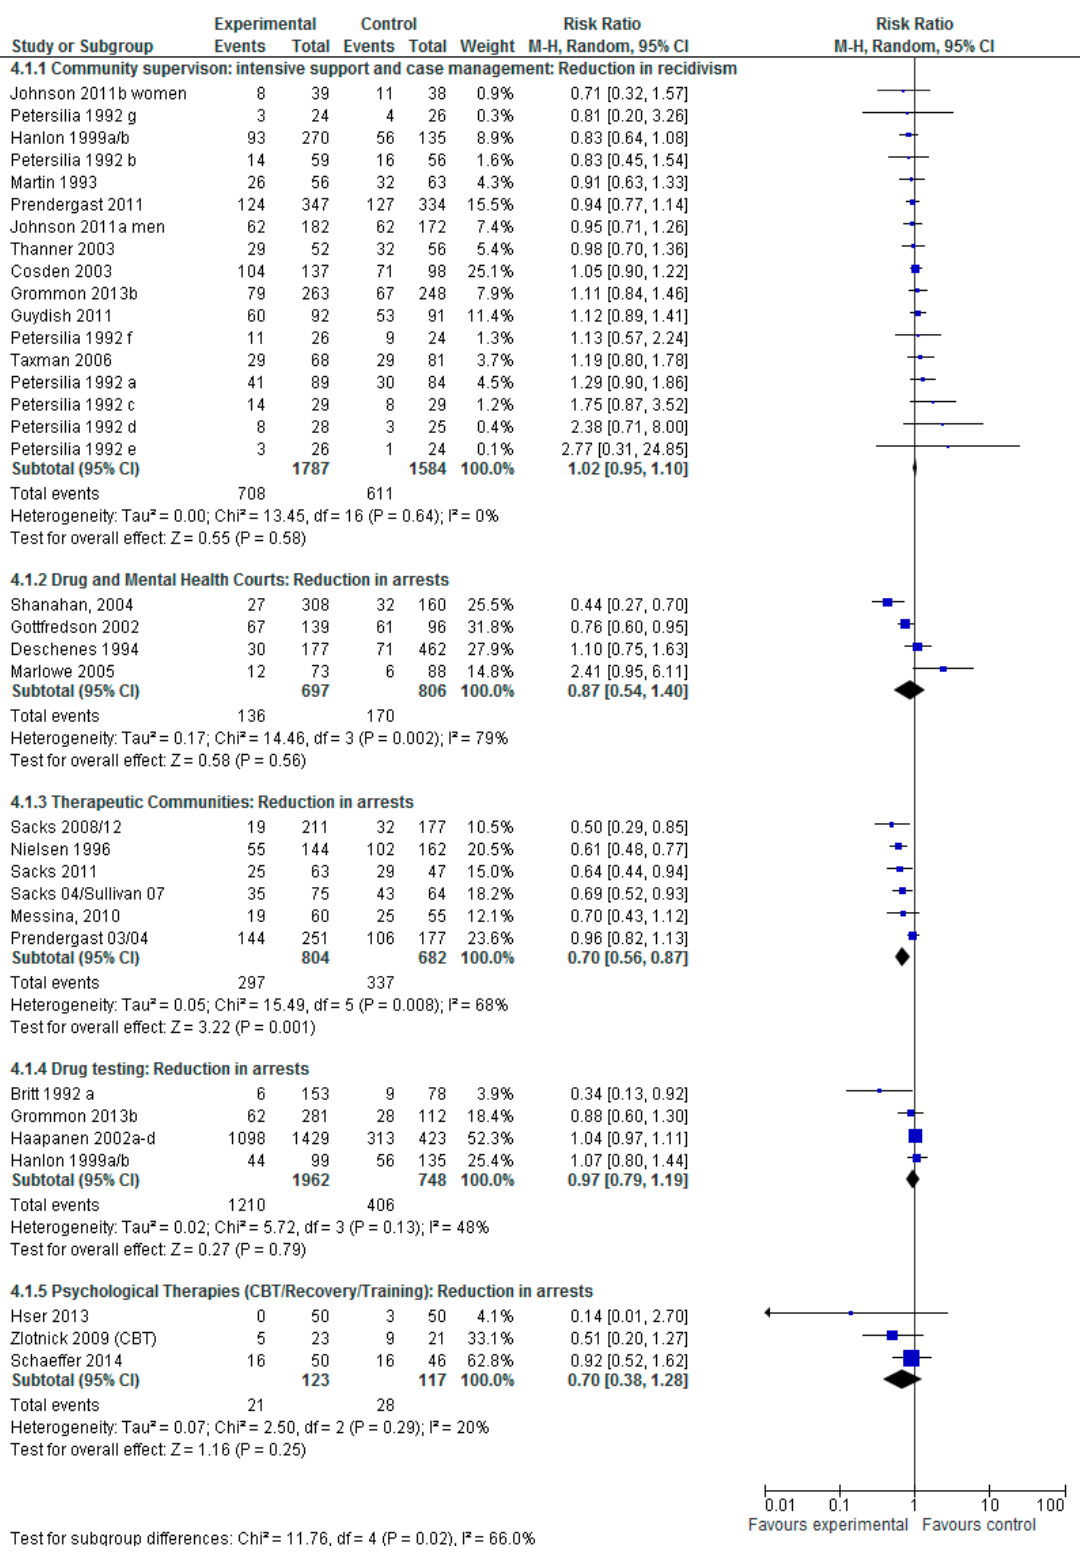
Figure 5. Does Intervention type impact on subsequent criminal activity?